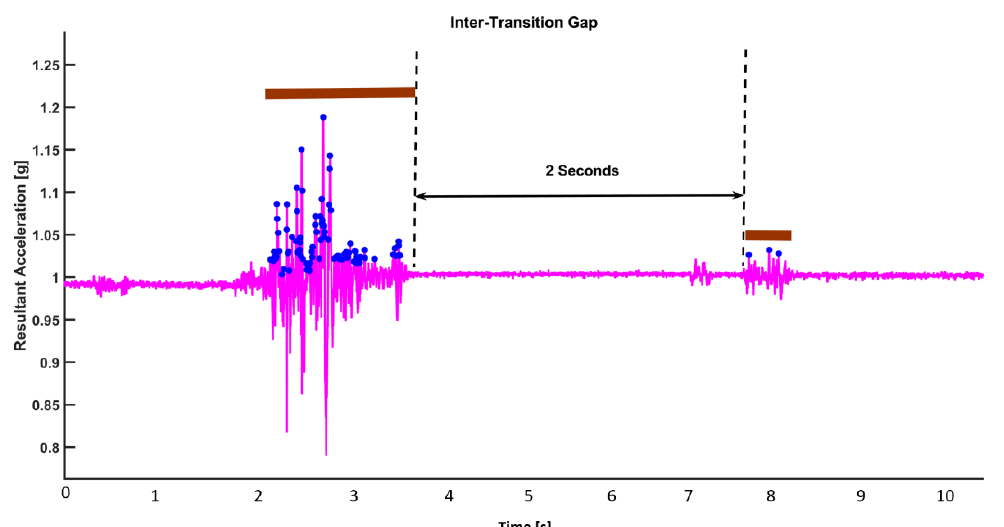
Figure 3. Inter-transition interval and transition durations in a transition.